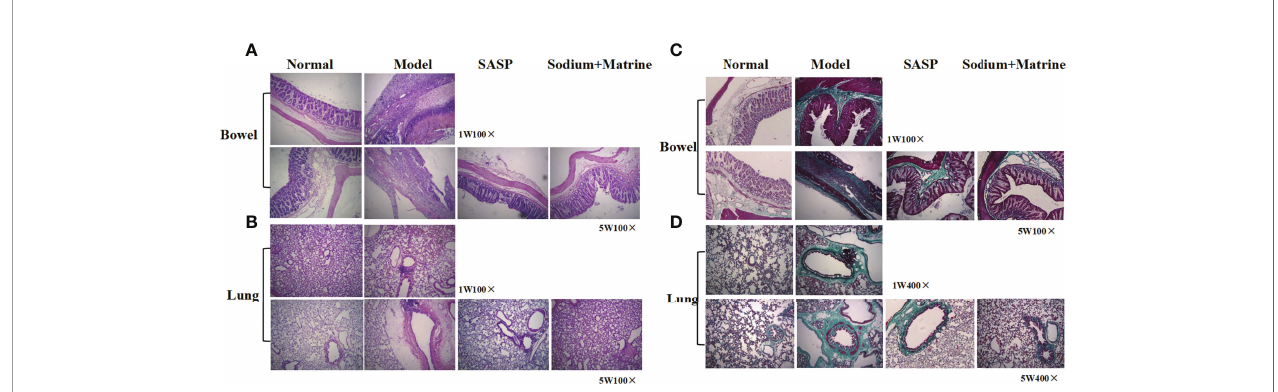
FIGURE 1 | Pathological and fi brosis changes of lung and bowel tissues in rats with ulcerative colitis. UC models were established with the mucous membrane of colon allergize combined with TNBS-alcohol enteroclysis. (A) Intestinal and (B) lung tissues with HE staining; (C) Intestinal and (D) lung tissues with Ma Song